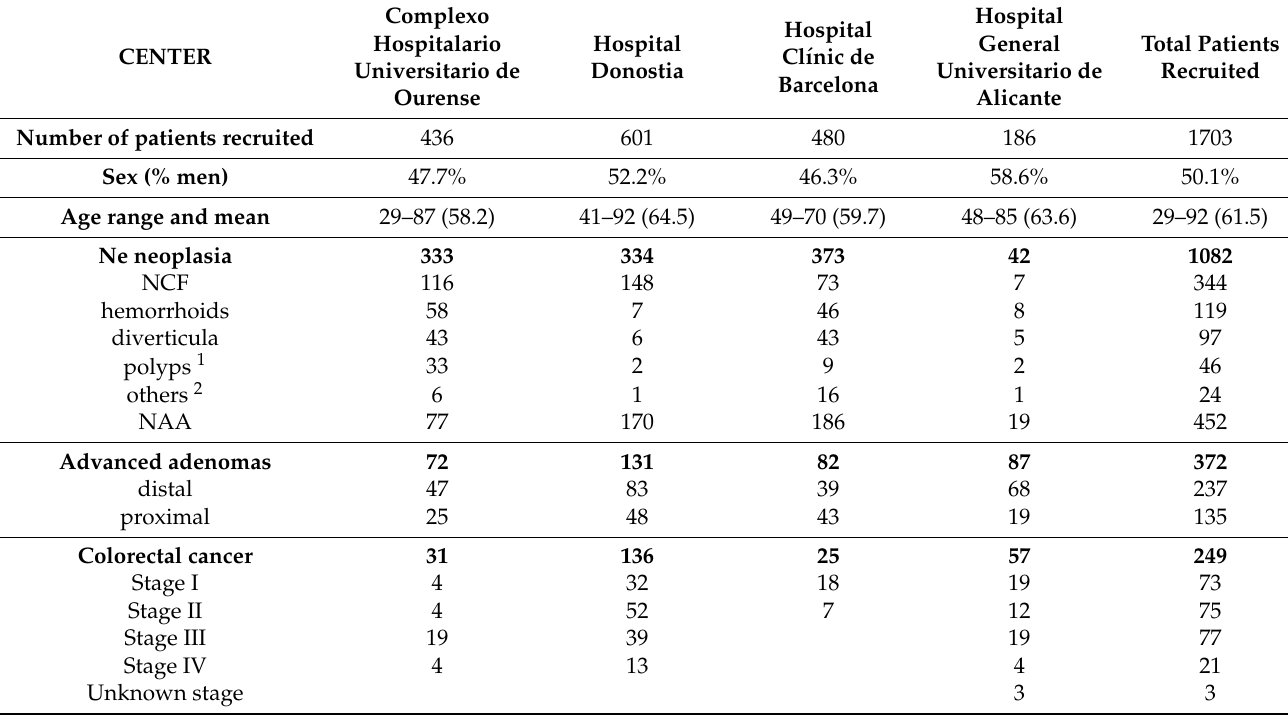
Table 1. Epidemiological and clinical characteristics of the patients recruited per